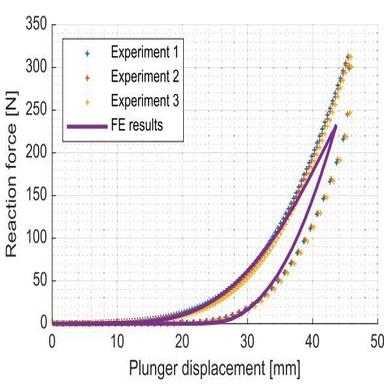
Global reaction force vs displacement of the plunger: comparison between experimental and finite element results. The coefficient of determination R2 is 0.97.